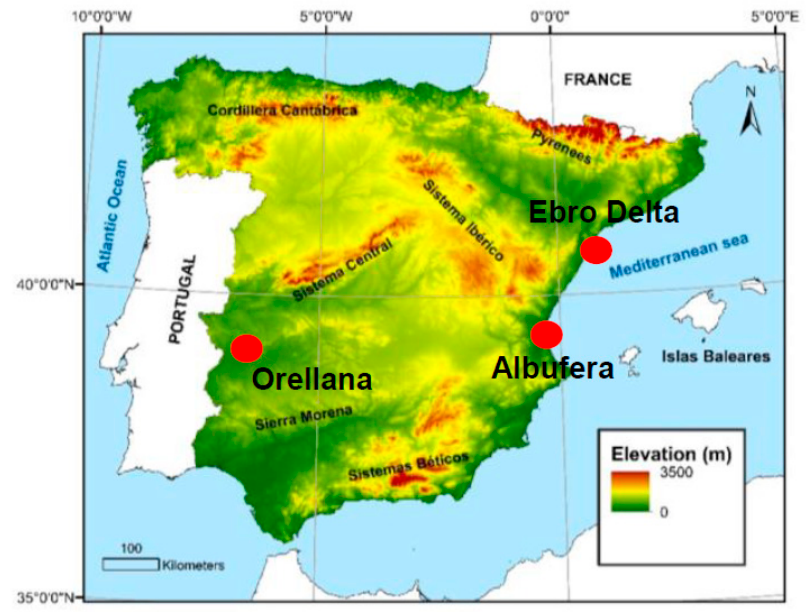
Figure 1. Study sites: Ebro Delta, Tarragona; Albufera, Valencia and Orellana, Badajoz (Spain). The Albufera Natural Park is located in the eastern coast of Spain (Figure 1). It is a 21,000 ha wetland ecosystem, including a mixture of approximately 14,500 ha of rice fields, a 2800 ha lagoon in the northern part and natural areas close to the coastline [40]. The whole area is surrounded by urban areas and other crops (Figure 2). The climate is Mediterranean, with similar features than those in the Ebro Delta. The precipitation is normally between 400–500 mm/year, and it is mostly concentrated in autumn and spring.